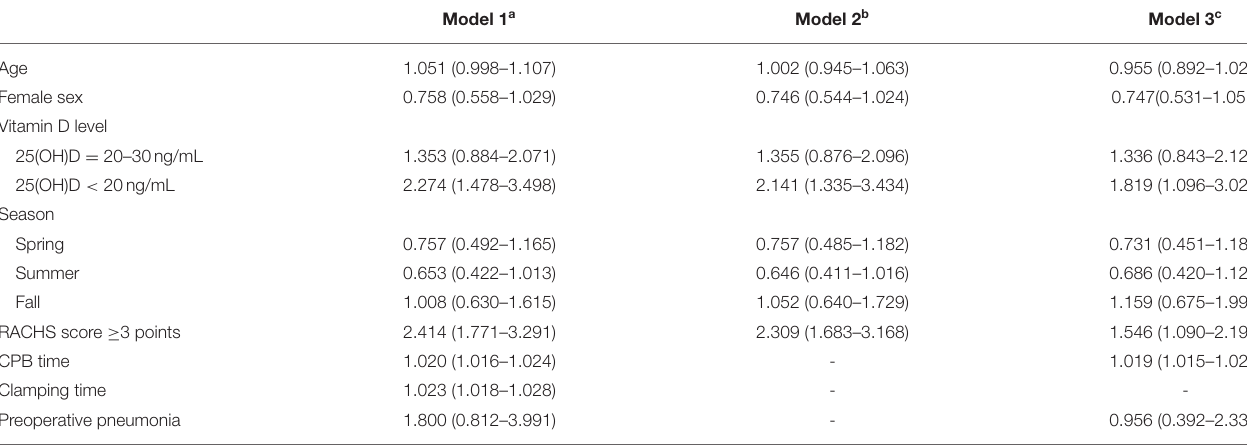
TABLE 3 | Logistic regression analysis of the risk factors for VIS max within 24h after